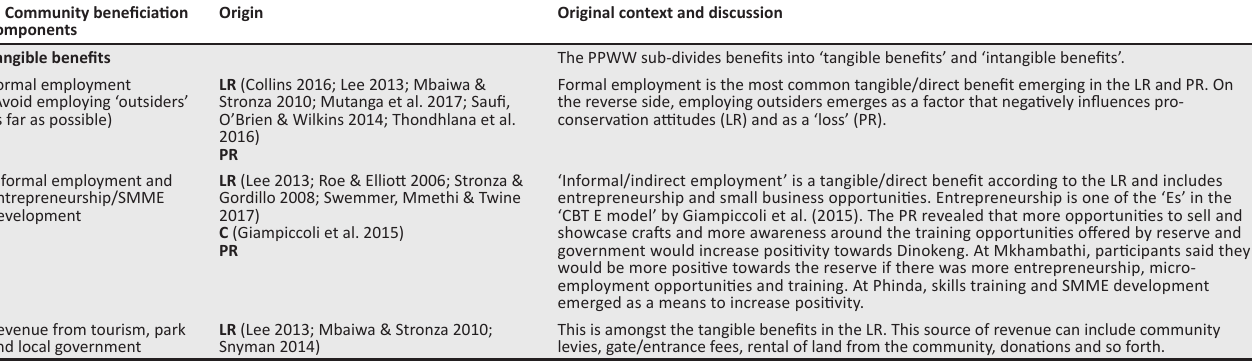
TABLE 3: Layer 3 and components used to build the People Parks Win-Win